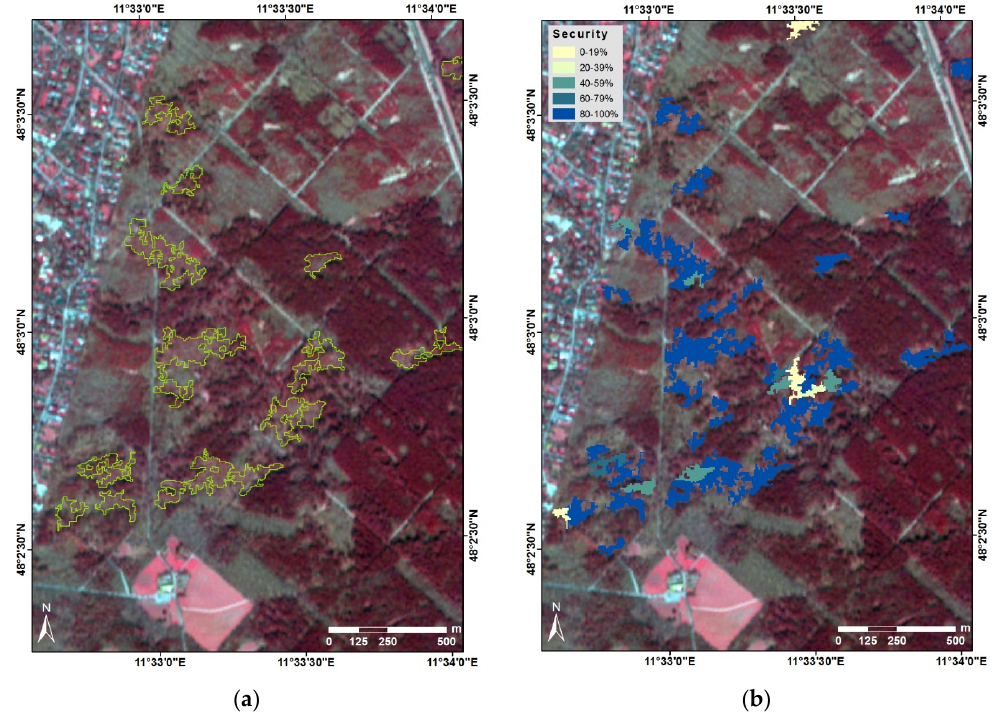
Figure 5. Object ‐ based change detection results for an exemplary area in Munich South . Polygons are overlaid on false color composite of post ‐ storm scene (band combination: near infrared—red—green). ( a ) Reference windthrow areas greater than 0.5 ha; ( b ) detected windthrow areas greater than 0.25 ha, the minimum mapping unit of the segmentation, with classification margins. Table 9. Contingency table of binary classifier for Munich South and Landsberg .